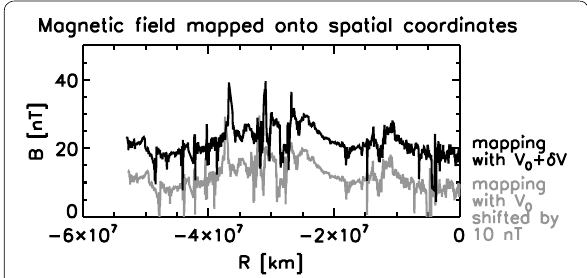
Fig. 2 Magnetic field data (only the magnitude is plotted) mapped onto the streamwise spatial coordinates using the total flow velocity in black (including the mean constant flow velocity field V 0 and the fluctuating field δ V and using the mean constant flow velocity in grey (Taylor’s hypothesis). Only the radial direction away from the Sun is considered here